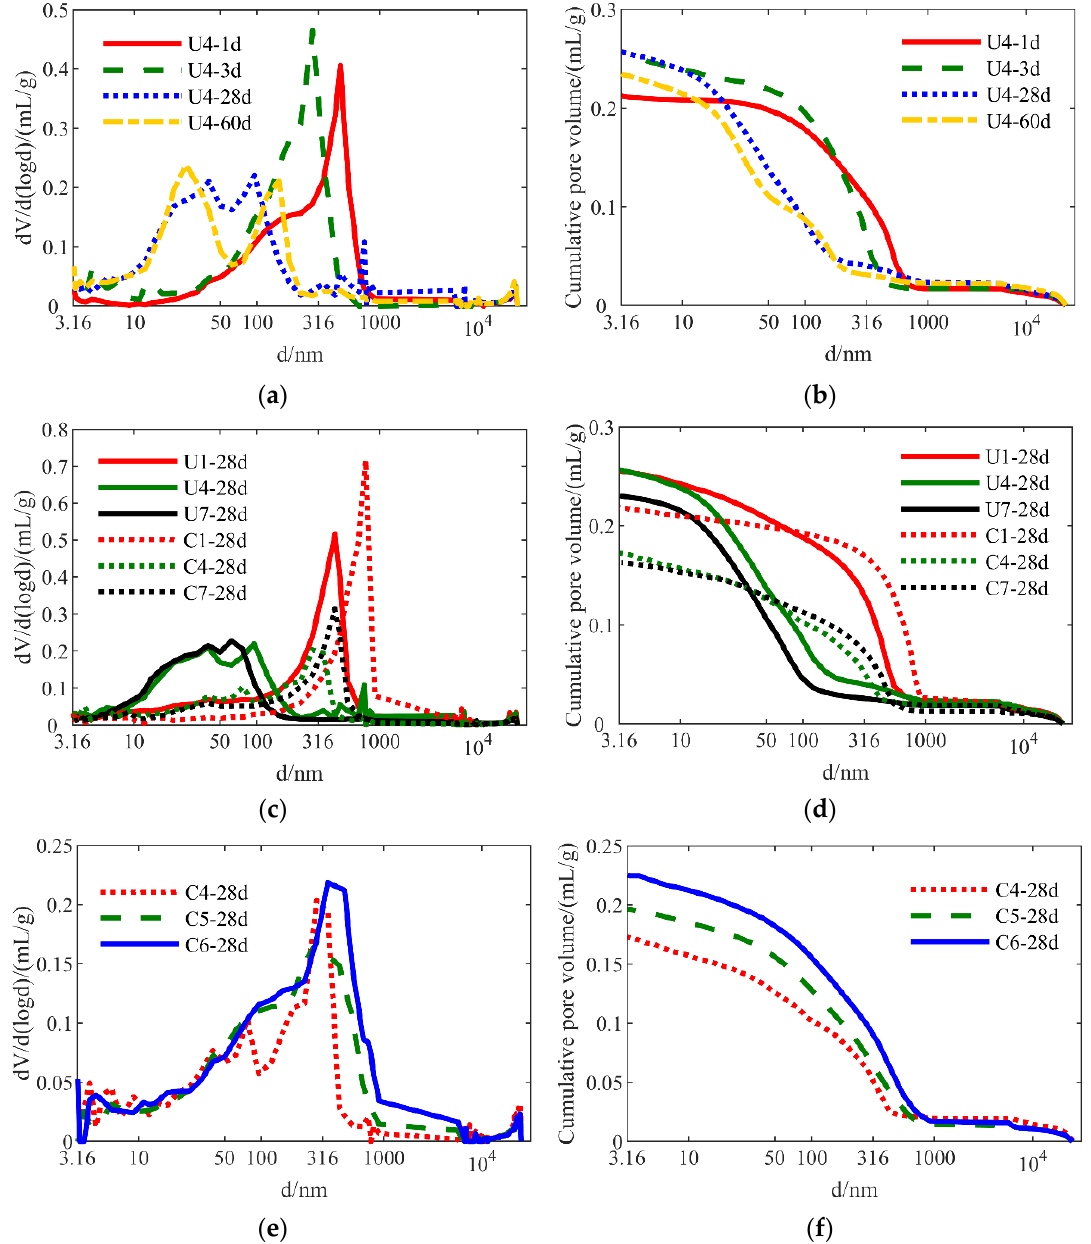
Figure 10. PSD curves and cumulative pore volume curves of the hydration ‐ cured and carbonation ‐ cured samples; ( a ) and ( b ): U4 at different curing ages; ( c ) and ( d ): U1, U4, U7, C1, C4, and C7 at 28 d; ( e ) and ( f ): C4, C5, and C6 at 28 d.